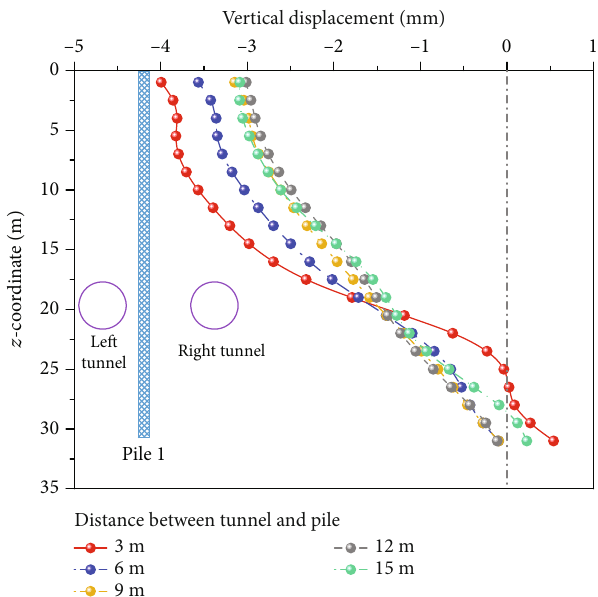
Figure 15: Vertical displacements of Pile 1 on completion of twin tunneling at di ff erent pile-to-tunnel distances.